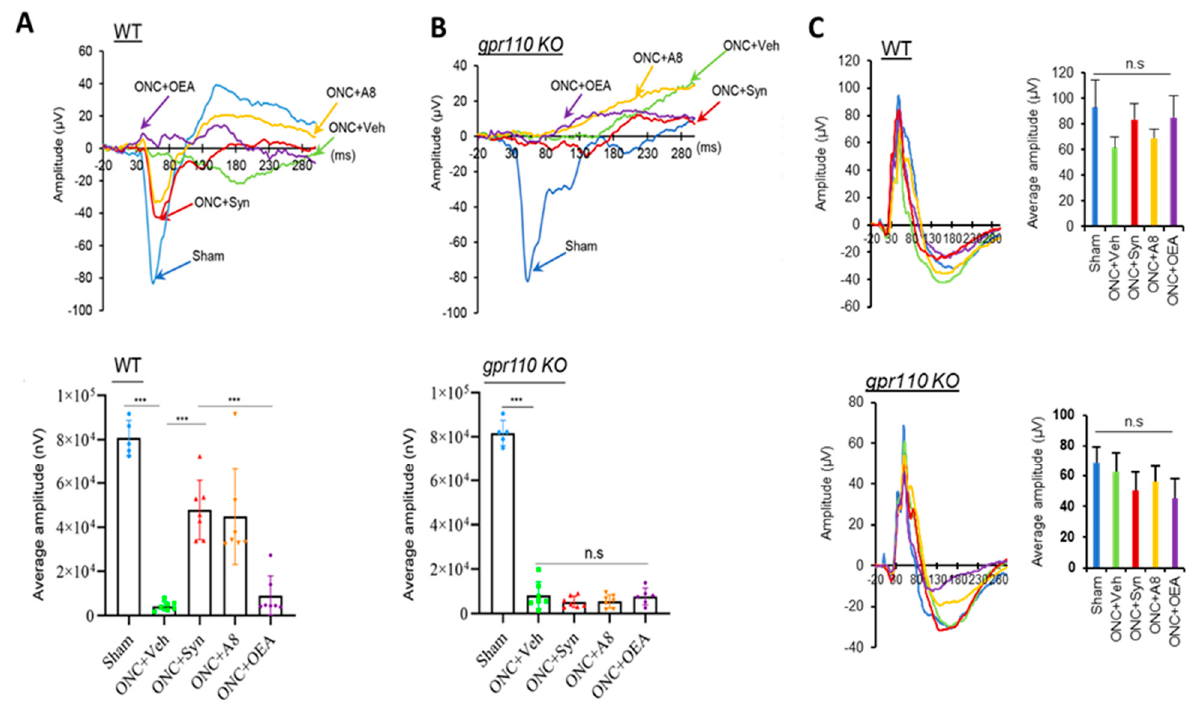
Figure 2. Intravitreal injection of synaptamide or A8 GPR110 dependently improved visual function impaired by ONC. ( A , B ), Representative VEP responses (top) and the mean amplitude (bottom) measured at 12 weeks after ONC in sham (blue), vehicle- (green), synaptamide- (red), A8-(orange) or OEA-injected (purple) C57BL/6 WT and gpr110 KO mice. ONC caused a drastic reduction in VEP compared to sham animals (83.3 ± 5.5 µV). At 12 weeks, WT mice injected with synaptamide (2.5 mg/kg) or A8 (0.03 mg/kg) showed improvement of VEP amplitude, but the gpr110 KO group did not show the same improvement. The improvement in the VEP amplitude was not shown in OEA-injected WT mice.